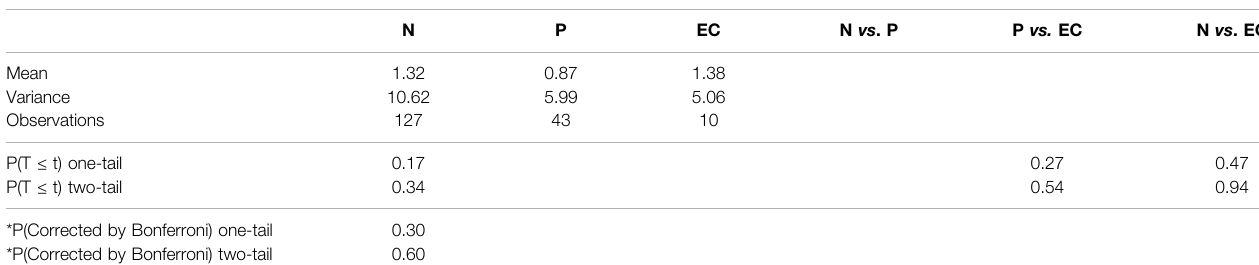
TABLE 5 | Measurement results within diseases categories